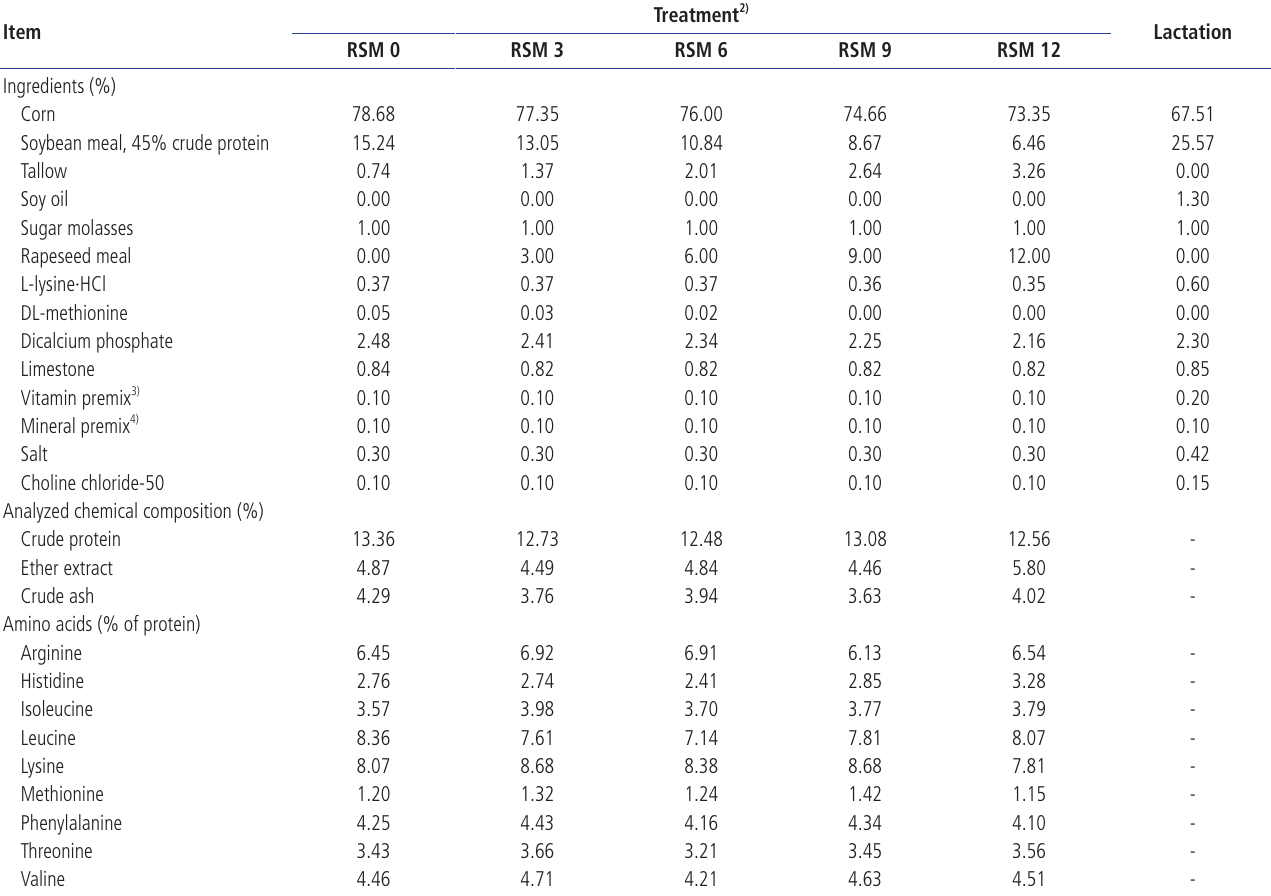
Table 2. The formula and chemical composition of experimental diets in gestation and lactation (as-fed basis) 1)